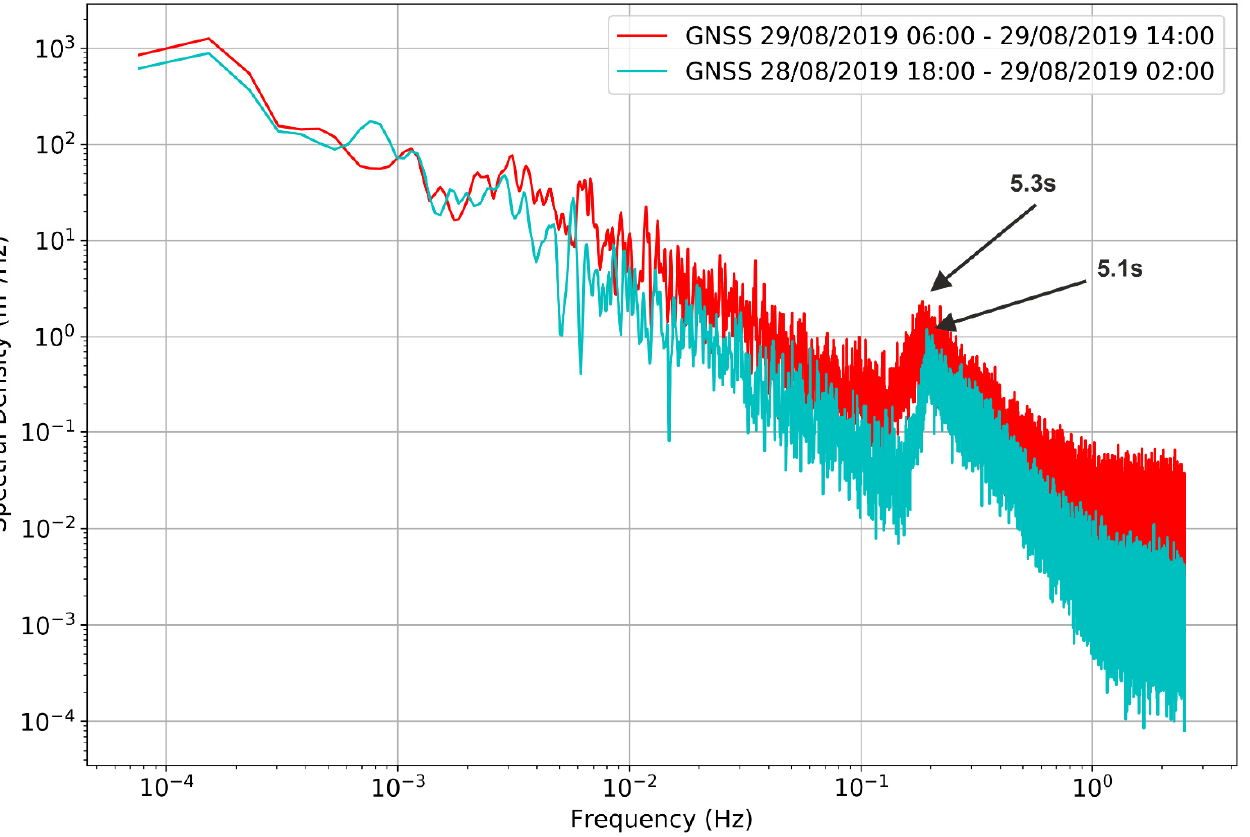
Figure 12. Spectral density for tidal cycle A (cyan) and tidal cycle B (red).